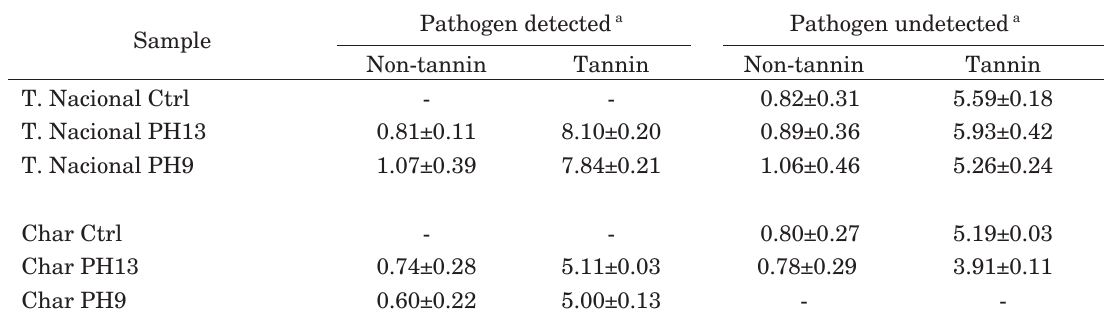
Table 3. Mean non-tannin and tannin content (mg g -1 wood) in healthy and infected plants from cv. Touriga Nacional (T. Nacional) and cv. Chardonnay (Char) infected at the trunk with Pa. chlamydospora strains PH13 and PH9. Results from control plants (Ctrl) are also shown.